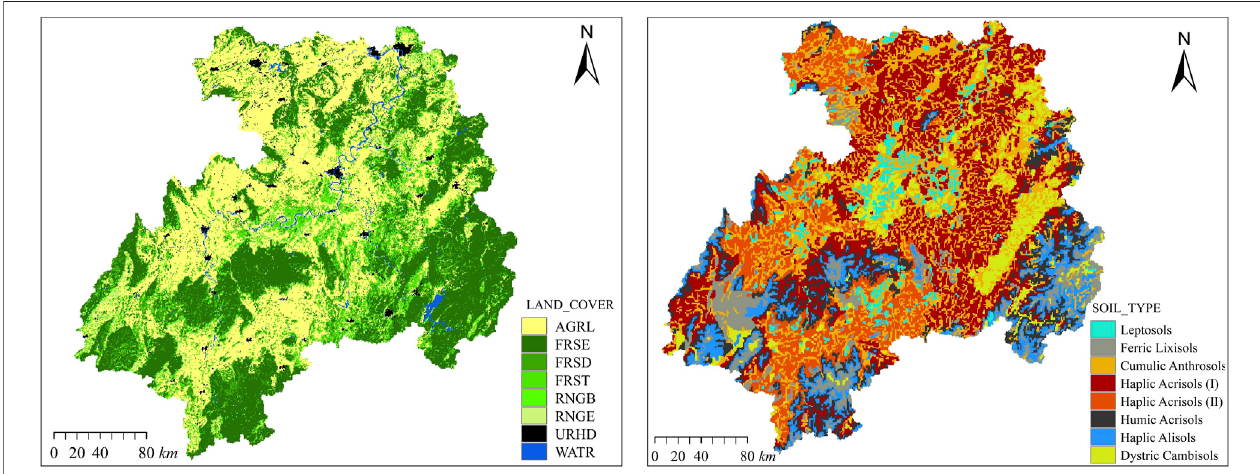
FIGURE 2 | Land cover map and soil type map of the Xiangjiang River